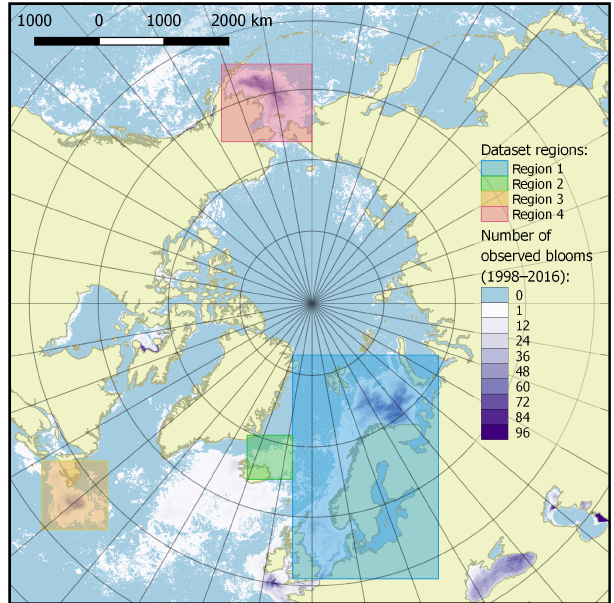
Figure 3. Dataset of target spatial regions. Regions are shown as coloured boxes, and the colour bar indicates the number of bloom observations in each pixel over the time period